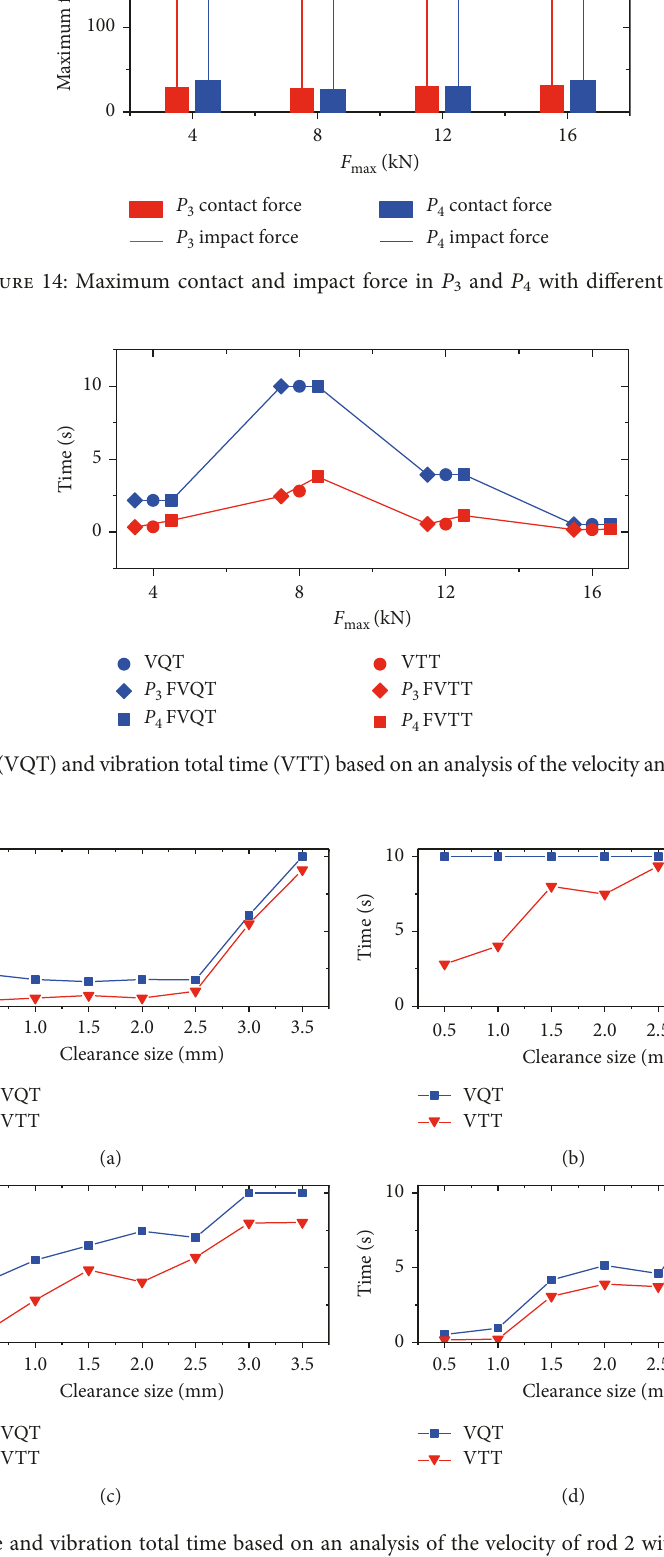
� 4kN; max : (a) F max